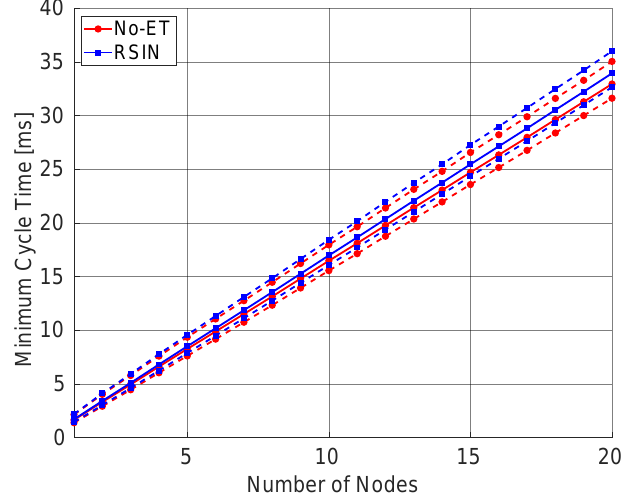
Figure 7. Minimum Cycle Time for a Prototype Industrial